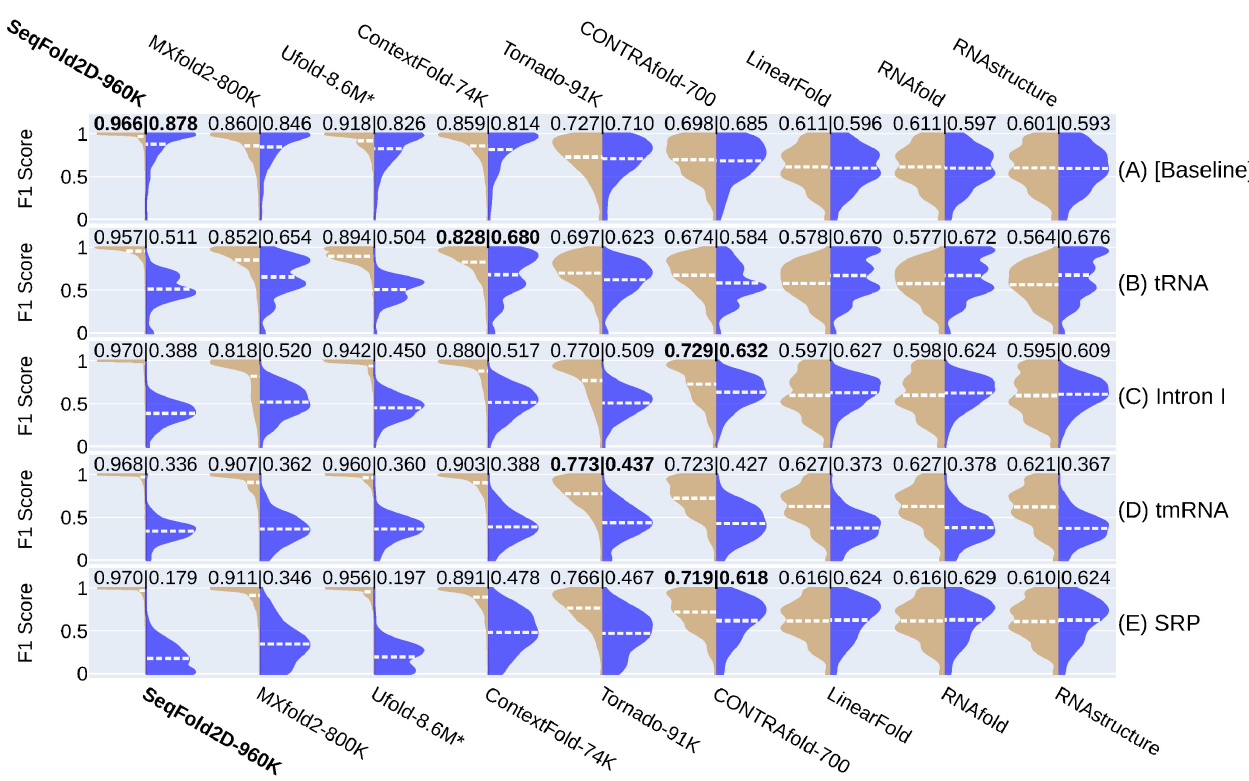
Fig 4. Illustrations of the TR (left, tan) vs. TS (right, blue) performances for selected learning and physics-based models at the cross-family level with the Strive-NR80 dataset. For each cross-family study, one RNA family is held out as the TS set and the rest eight families are used for model development (TR and VL). Each panel/row here shows one such study labelled by the TS family name (B-E), while the first panel, (A) [Baseline], shows a baseline study with randomly splits of all families for the TR, VL, and TS subsets. Panel A thus is de facto a cross-cluster study with all subsets derived from the same parent dataset. For each panel, the average TR and TS scores are shown at the top and highlighted for the learning-based model with the highest TS score (physics-based models excluded). All learning-based models are retrained with the numbers of parameters shown after names. It should be noted that, despite our best re- training efforts, the scores of MXfold2 and Ufold should be viewed as guides only as we are unable to match their reported performances when using the same datasets. Still, given the inverse correlation between TR and TS performances, their TR-TS gaps are expected to be under-estimates.